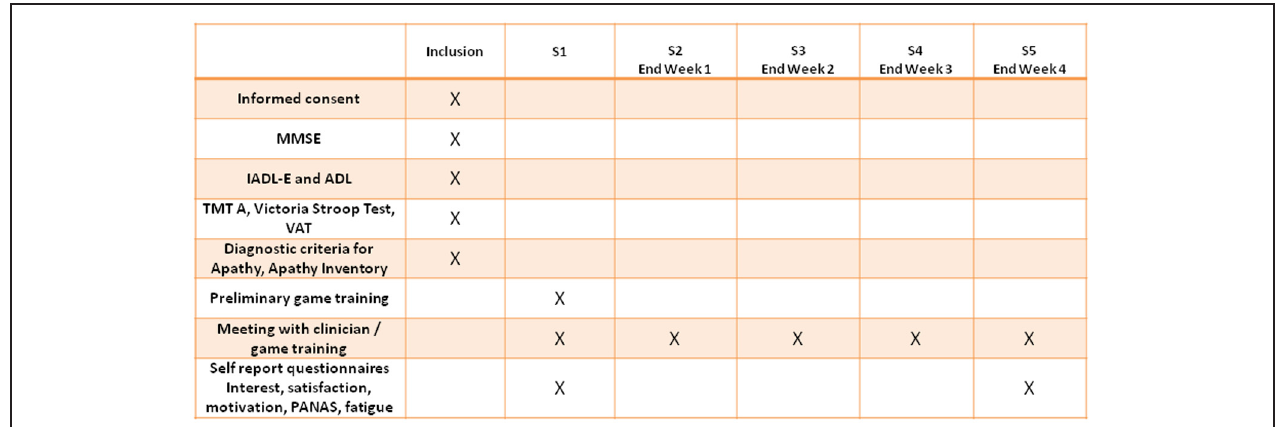
FIGURE 1 | Flowchart summarizing the activities performed in the different experimental